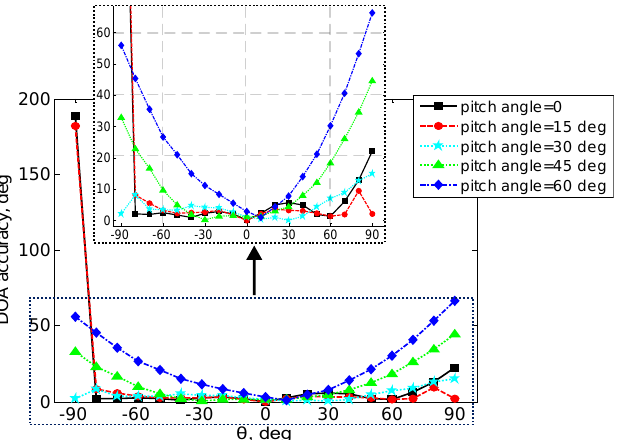
Figure 11. DOA estimation accuracy of patch array against DOA (θ) in different pitch angles.